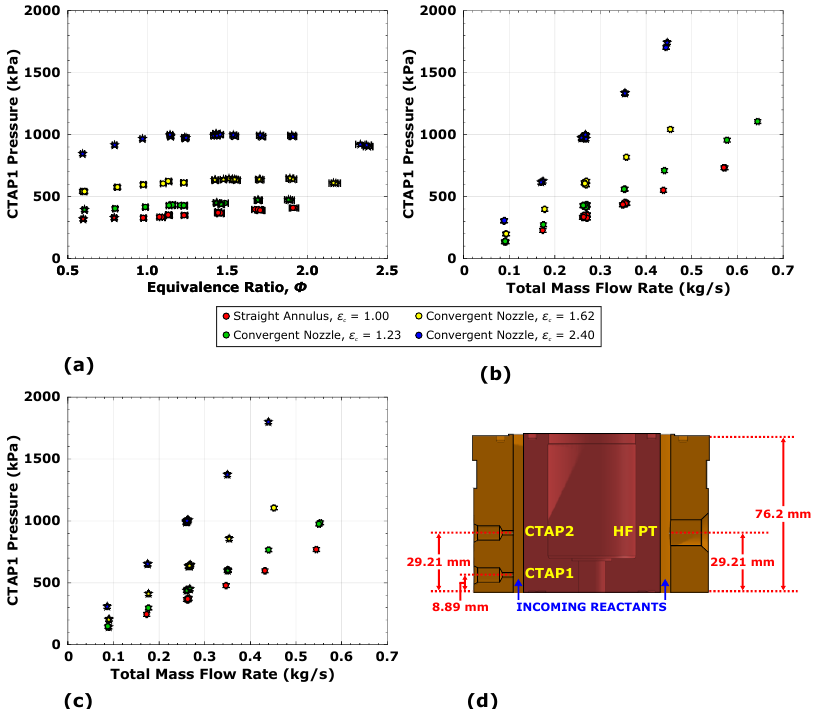
Figure 8. Equivalent average pressure measured at CTAP1 for the ( a ) equivalence ratio conditions and mass flow rate conditions at ( b ) φ = 1.15 and ( c ) φ = 1.5, as well as the ( d ) location of the measurement sites. Depending on the flow condition and convergent nozzle geometry, the engine operates in either a corotating ( • ) or counter-propagating mode ( (cid:63)